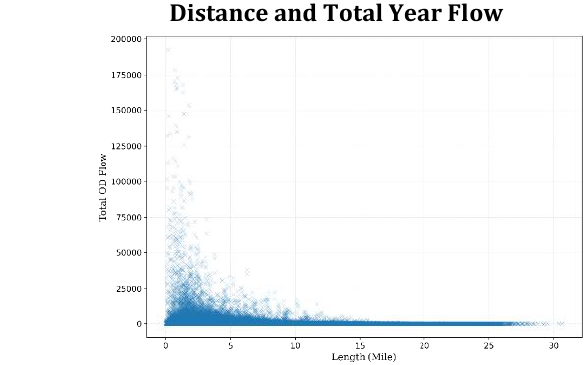
Figure 7: Relation between OD-pair Euclidean Distance and Total Year